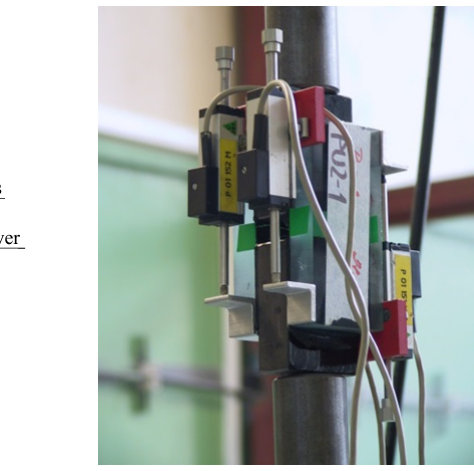
Fig. 3 Setup of the shear steel-glass connection tests.